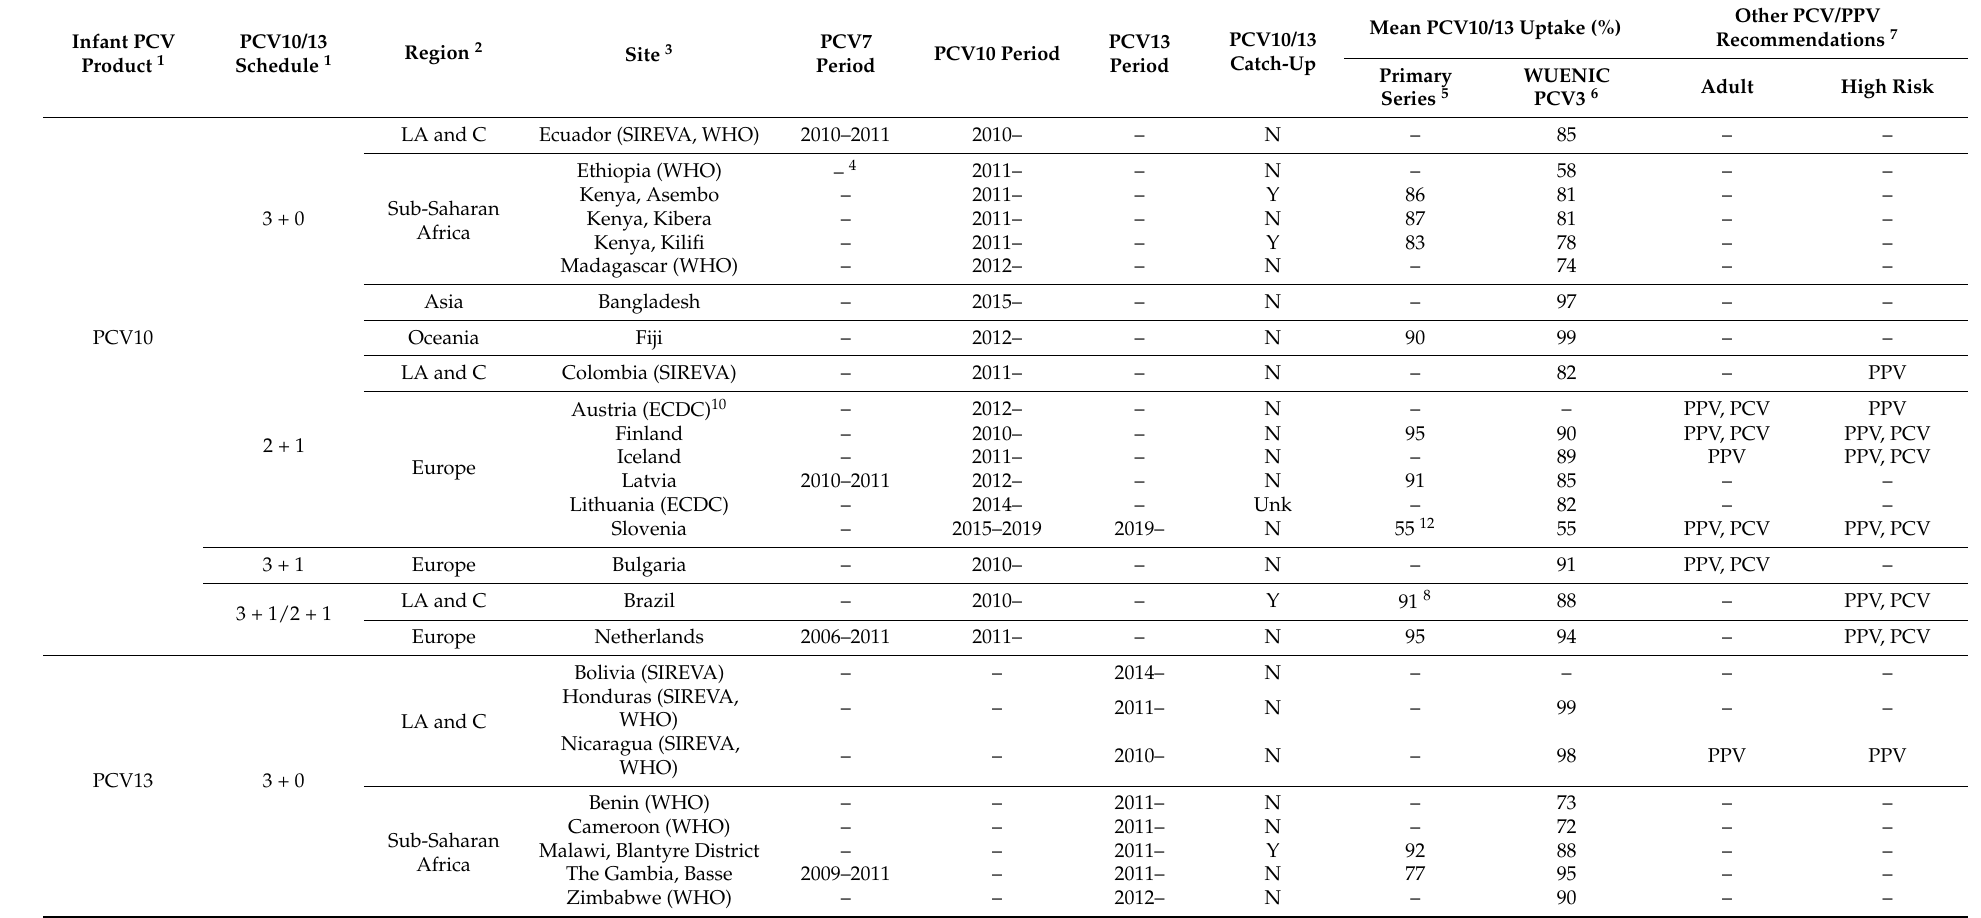
Table 5. Description of infant and adult pneumococcal immunization use for PSERENADE